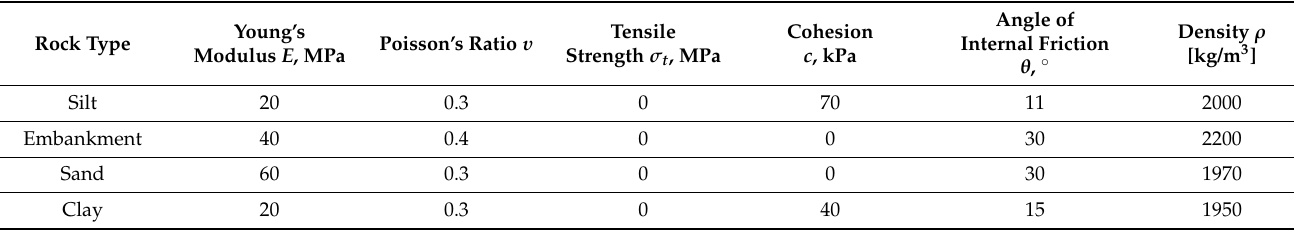
Table 3. Mechanical parameters of soils adopted for modeling.